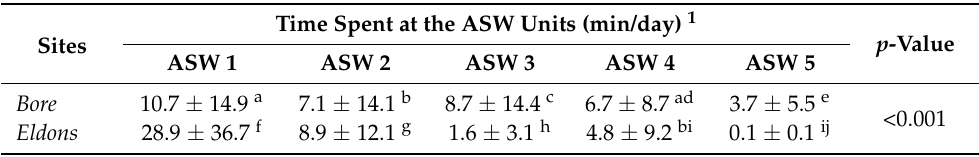
Table 2. Average daily time spent at the automatic supplement weighing (ASW) units (mean ± SD) by individual cows across two sites over 62 days of data collection.